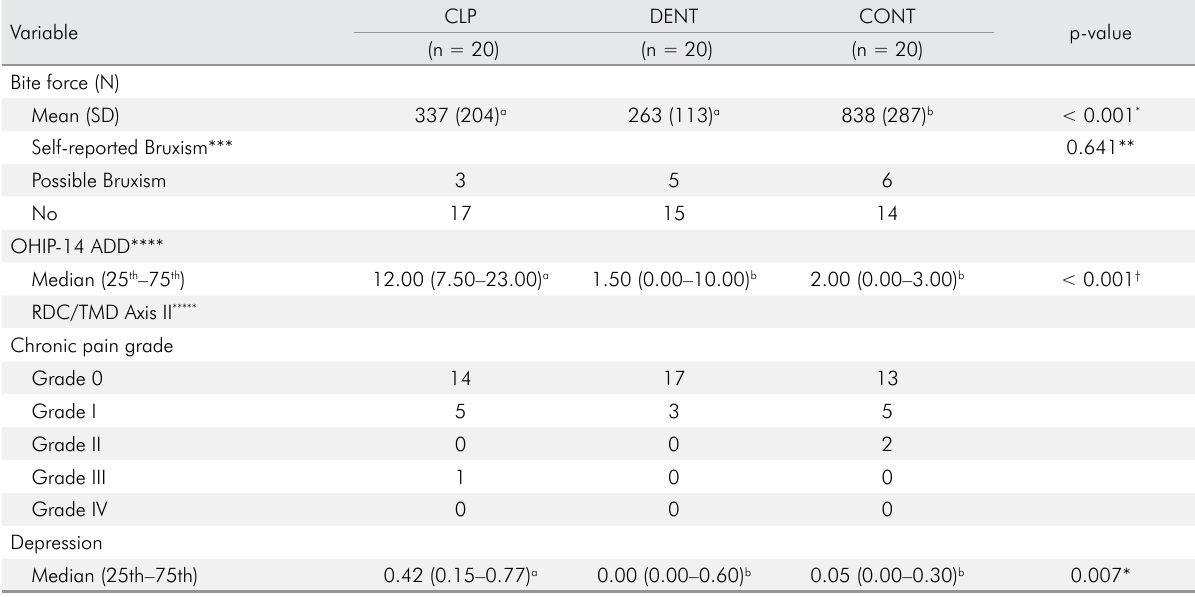
Table 1. Clinical characteristics of the sample (n =